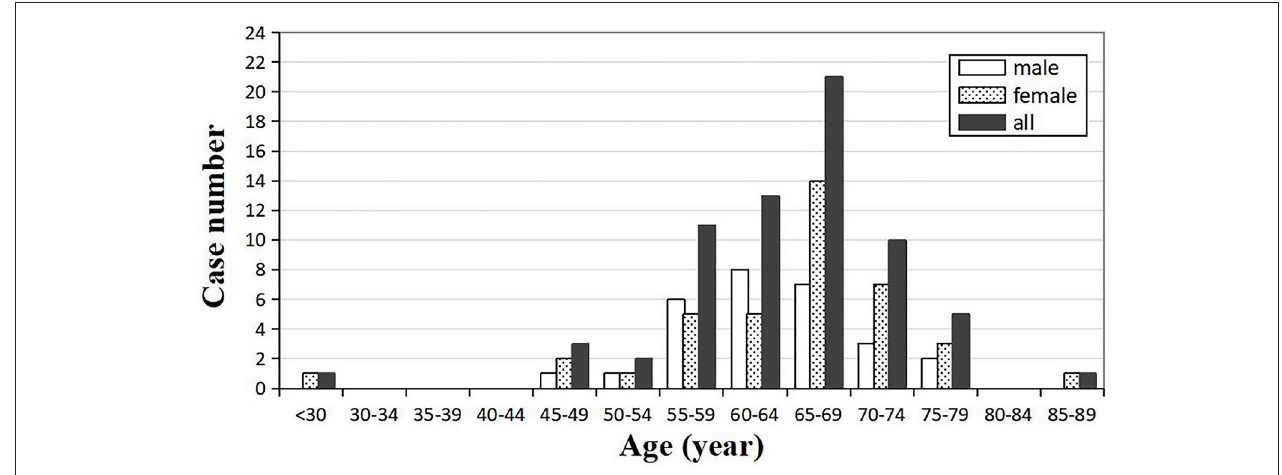
FIGURE 2 | Distribution of the onset age and gender-specific onset age in sCJD patients ( n = 67).